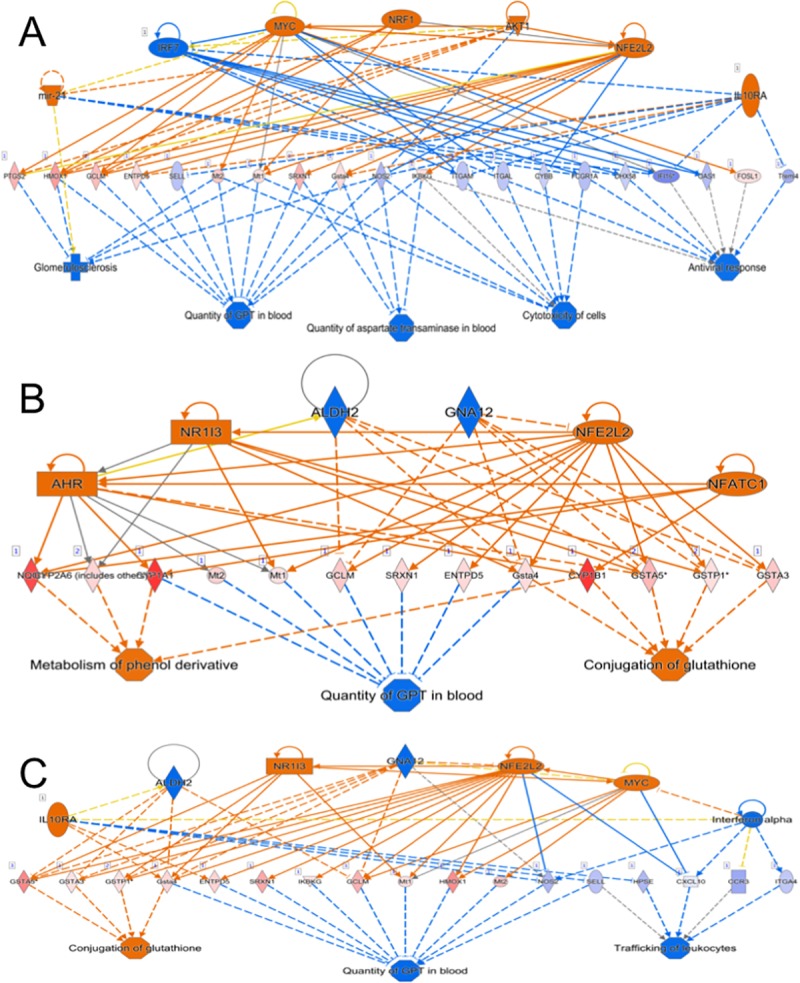
IPA network analysis investigating NRF2’s role in exposure-response genes after 1- and/or 5-day exposures.The red and blue coloration of the molecules in the middle row corresponds to the expression level: red indicates that the gene is upregulated due to smoke, and blue indicates downregulation due to smoke. (A): The regulator effect network map showing the NRF2-mediated oxidative stress response. This regulator was strongly predicted to regulate the pooled list of exposure-response genes significant after 1 and/or 5 days. The red and blue coloration reflects the expression level after 1 day of exposure. (B): The regulator effect network map showing the factors involved in regulating the cellular response, mediated by NFE2L2 (NRF2), after 1 day of exposure. (C): The regulator effect network map showing the factors involved in regulating the oxidative response, mediated by NFE2L2 (NRF2) after 5 days of exposure.